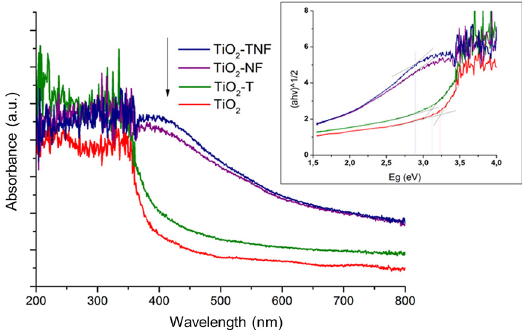
pristine, TiO -T, TiO -NF and 2 2 2